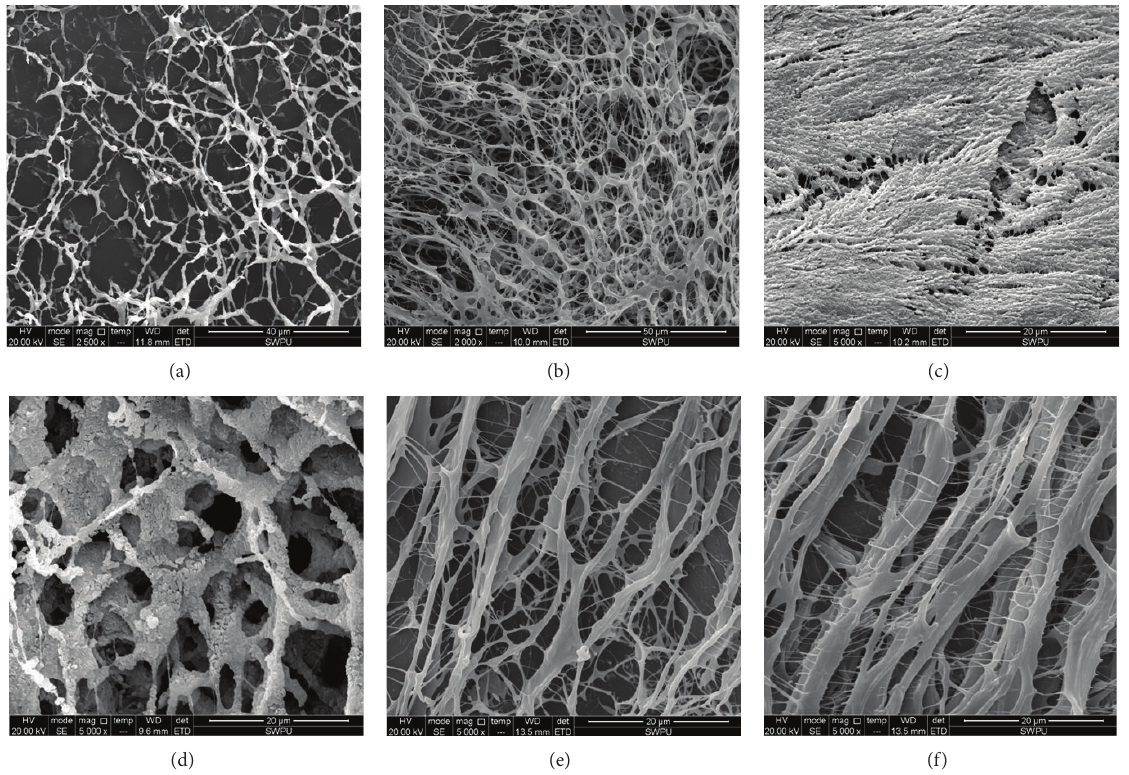
Figure 14: ESEM images of poly(AM/DMDCC) at different experimental conditions; (a) 0.5DM12.7 with 0.075 gdL −1 ; (b) 0.5DM12.7 with 0.15 gdL −1 ; (c) 0.75DM12.8 with 0.15 g dL −1 in 2g dL −1 salt solution; (d) 0.75DM12.8 with 0.75 g dL −1 in 2g dL −1 salt solution; (e) 0.5DM12.7 with 0.5 g dL −1 in 8 mM SDS solution; (f) 0.75DM12.8 with 0.5 g dL −1 in 8mM SDS